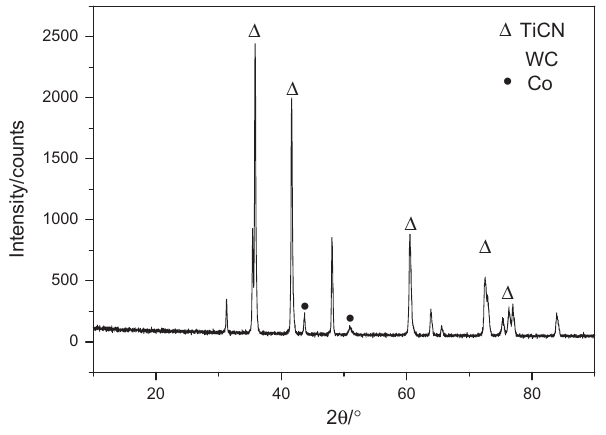
Figure 2: XRD patterns of the gradient layer.